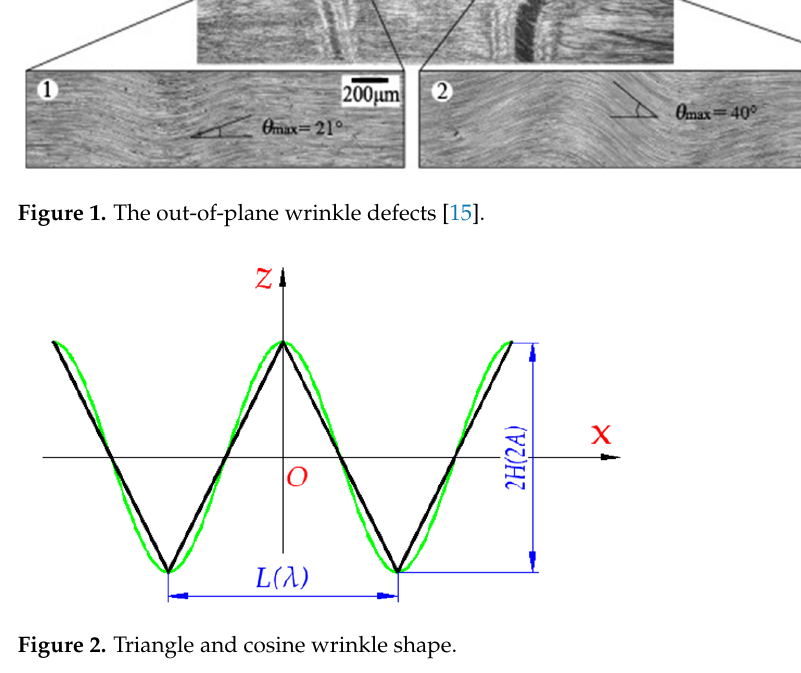
Figure 2. Triangle and cosine wrinkle shape.